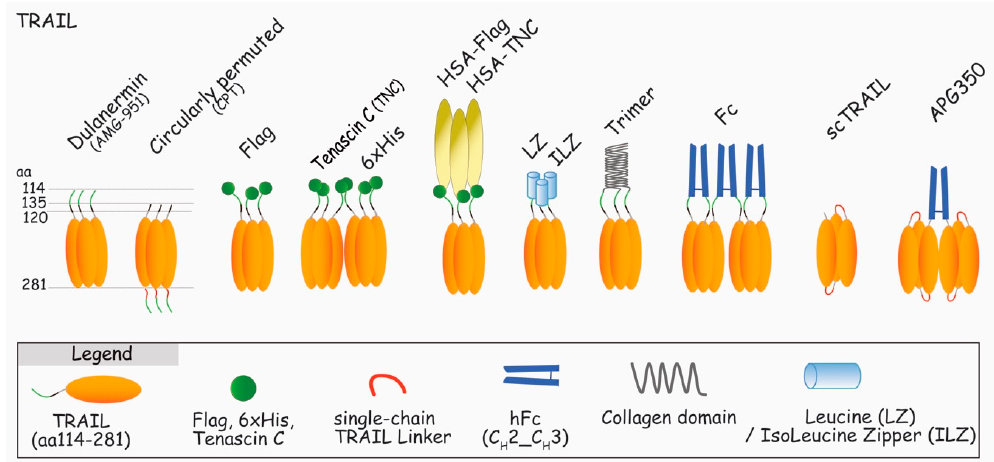
Figure 4. Schematic representation of the main TRAIL recombinant proteins assessed in clinical trials or used in laboratories to induce apoptosis through DR4 and/or DR5. Dulanermin (TRAIL aa114-281) [65,66], circularly permuted TRAIL (CPT, TRAIL aa135-281-linker-TRAIL aa122-135) [67], Flag-TRAIL [68], TNC-TRAIL [61], 6xHis-TRAIL [55], HSA-TRAIL [69], Leucine Zipper and Isoleucine Zipper-TRAIL [15], Trimer-TRAIL [70], Fc-TRAIL [63], Fc-sc-TRAIL [71], and AGP350 [40].